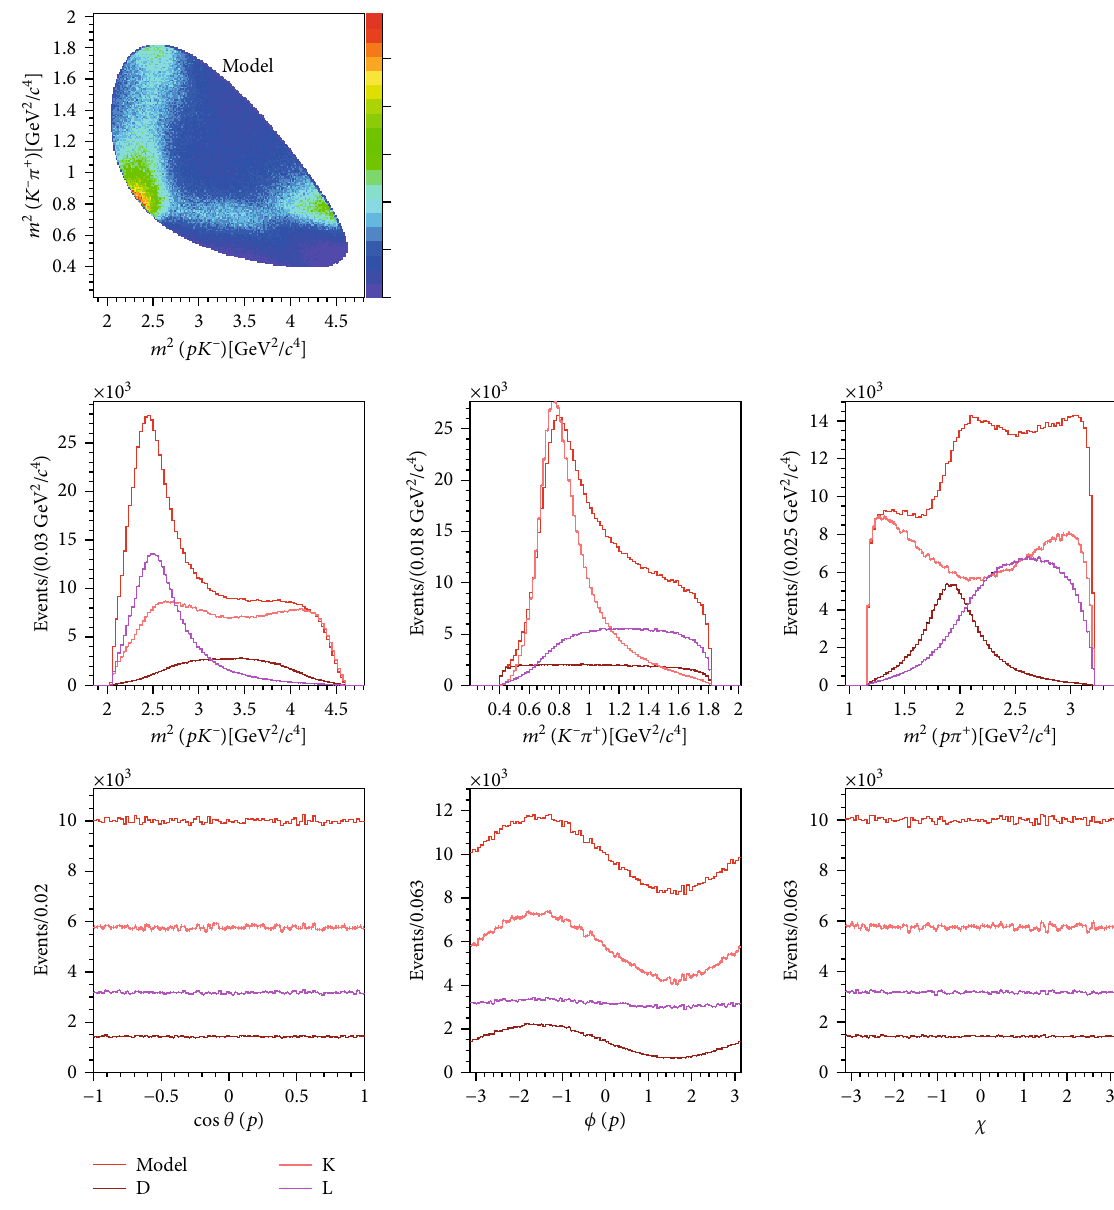
⟶ pK − π + toy amplitude model projections for P Figure 5: Λ + c